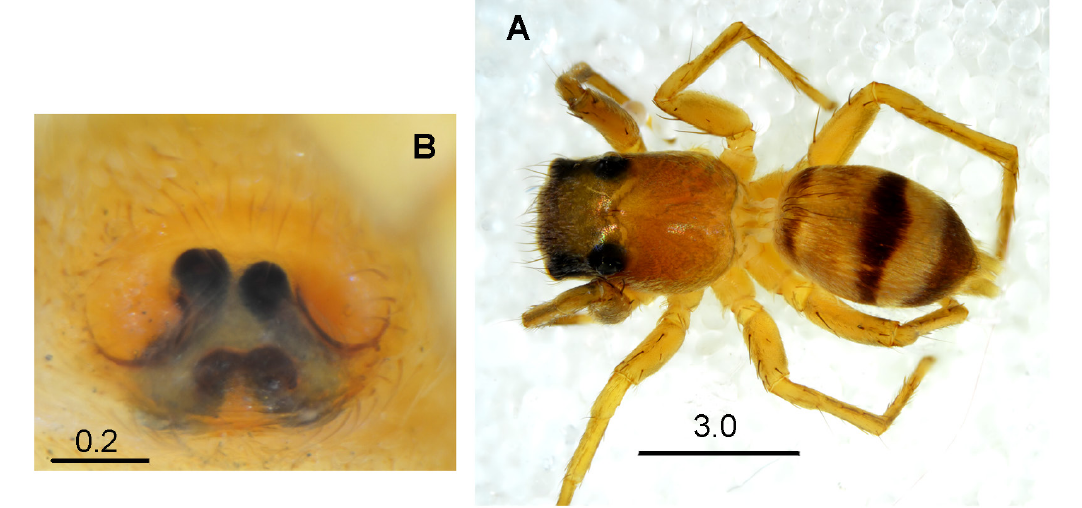
Fig. 36. Mexcala caerulea (Simon, 1901), ♀ (MNHN). A . Habitus, dorsal view. B .